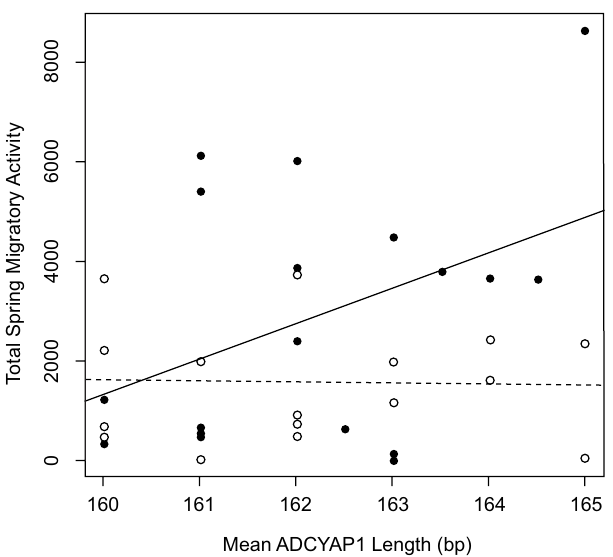
Figure 5. ADCYAP1 and individual variation. Plot shows mean allele length of ADCYAP1 against individual migratory restlessness score for Oregon juncos from the migratory population at Laguna Mountain, CA, USA (solid circles, solid line) and the sedentary population in San Diego, CA, USA (open circles, dashed line). Mean allele length marginally predicts migratory behavior in the Laguna Mountain, but not San Diego, populations.